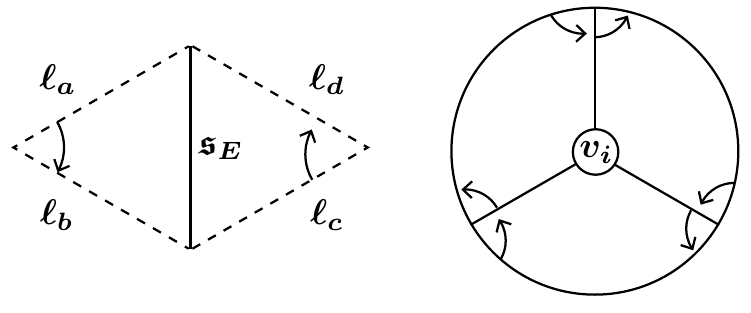
Figure 30 . (Left) Shift map s E on the E -th edge given by (D.22). (Right) Simultaneous shift-maps on all edges connected to v i do not change the bridge lengths f ‘ E g